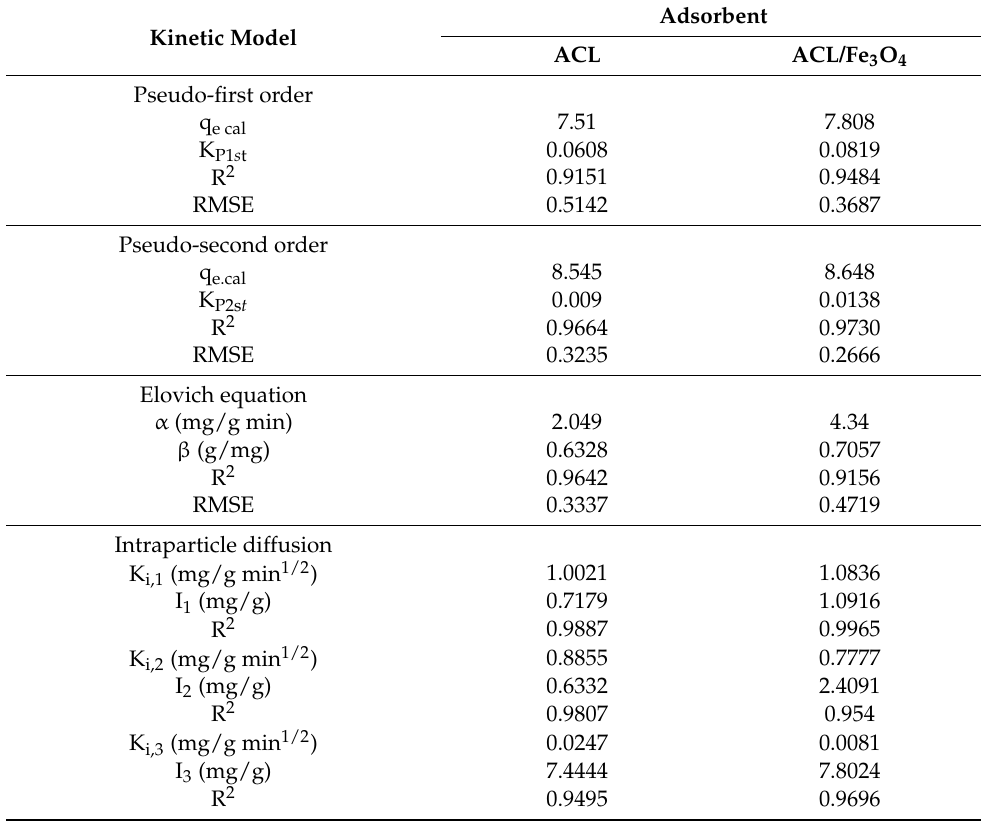
Table 1. Kinetics constants and parameters determined using kinetic models for the adsorption